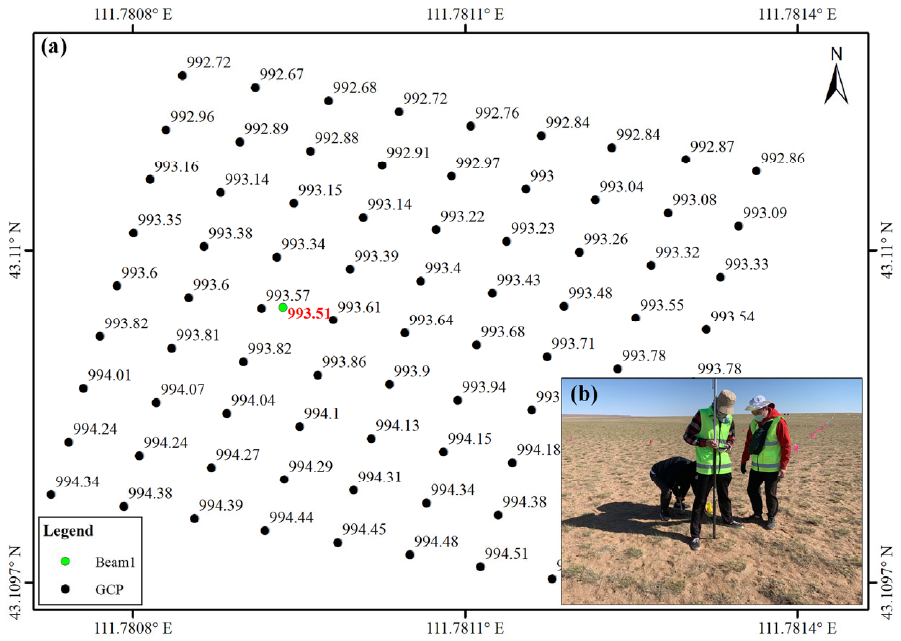
Figure 4. The GCPs around a GF ‐ 7 laser footprint. ( a ) The GCP array surrounding laser point 203168336.67 of GF ‐ 7 laser beam 1. ( b ) A picture of the GCP measurement.